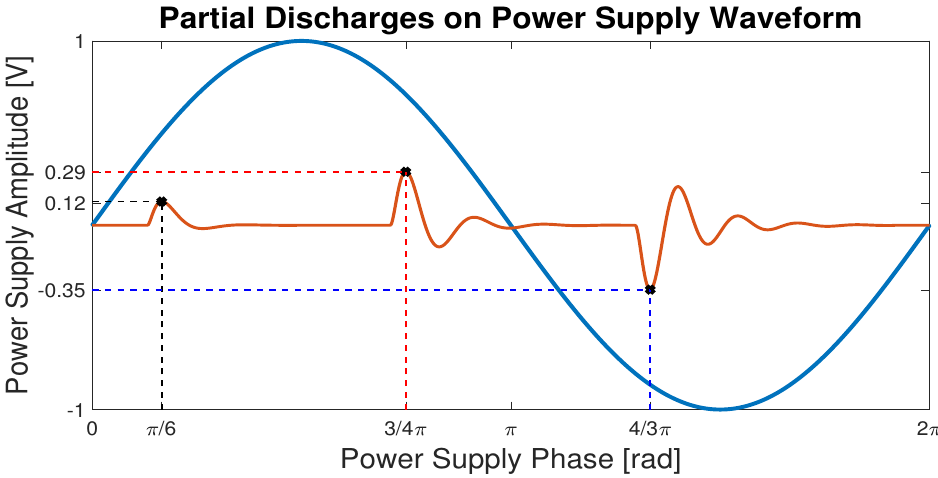
Figure 1. PD impulses over the power supply voltage